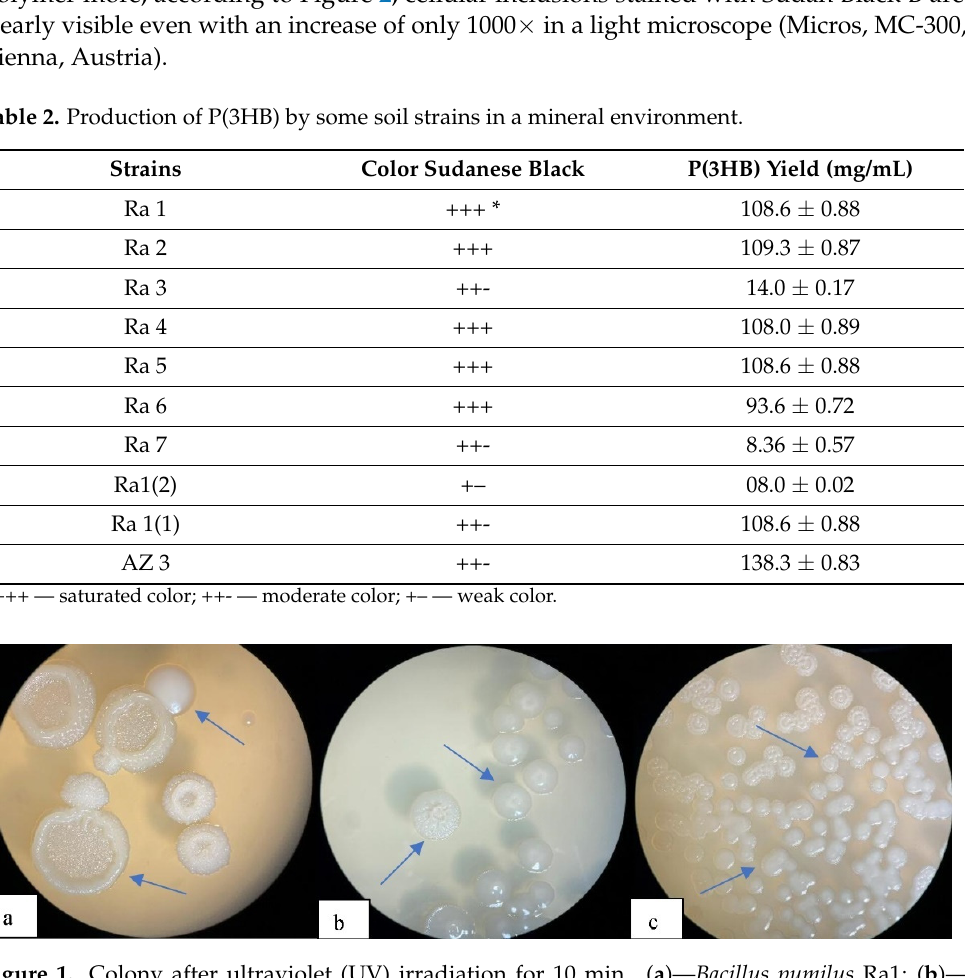
of color saturation Sudan Black B: RA 5 and RAF 5 from Bacillus megaterium Bm 5, RAZ 3 from Azotobacter chrocococcum AZ 3 and wild-type Bacillus pumilus Ra 1. 3.1.2. The Effect of the Concentration of Bean Broth on the Concentration of P(3HB)